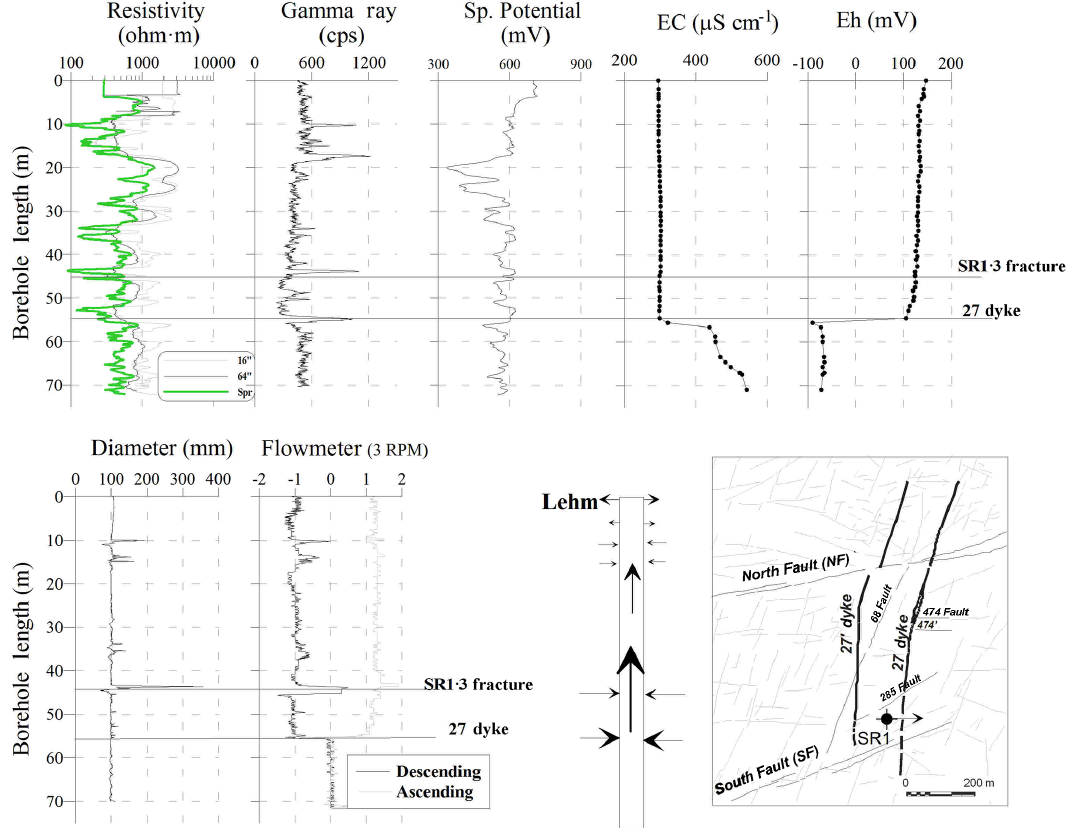
Figure 4. Some of the chemical and geophysical logs recorded at borehole SR1, which helped to identify dyke 27 and fracture SR1-3. The chemical logs only display the effect of dyke 27, because all upper water (including SR1-3) is mine water. The effect of both structures can be noticed in other logs, especially in the gamma log, due to the fracture filling. Flowmeter values, recorded with an upward flow rate of pumping indicate little water flow beneath dyke 27. The same applies to a lesser extent to fracture